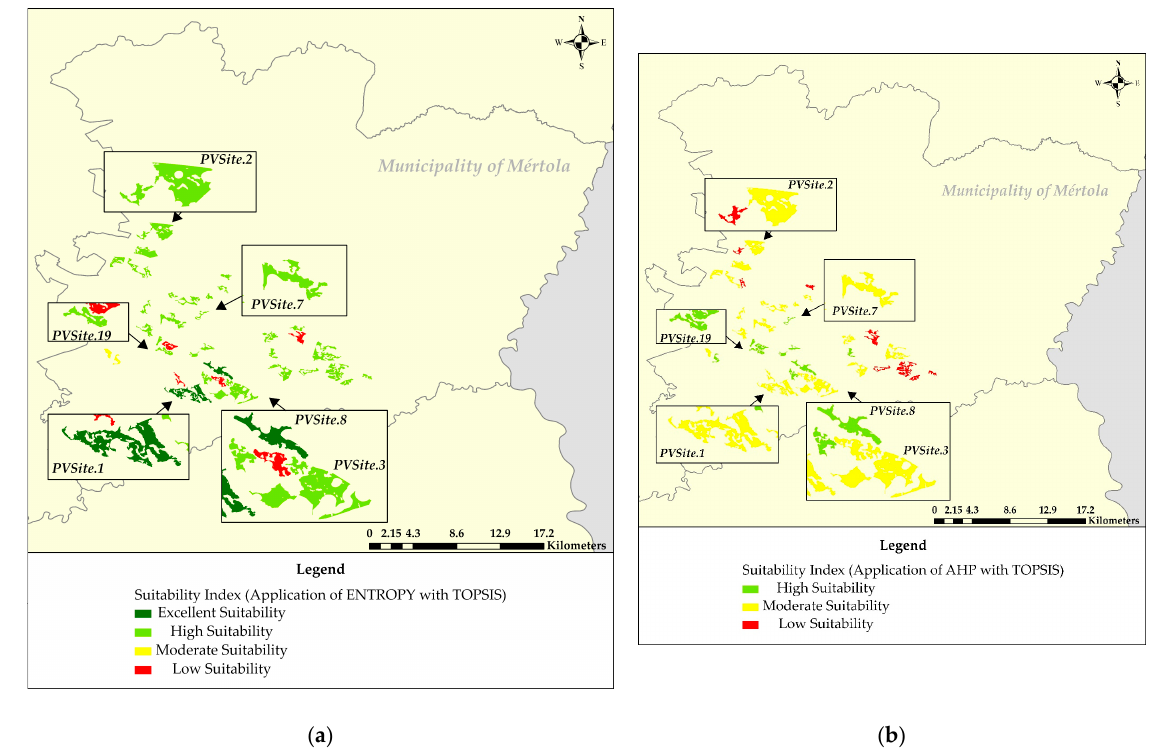
Figure 7. Suitability index (SI) spatial allocation based on the application of ( a ) ENTROPY with TOPSIS and ( b ) AHP with TOPSIS.